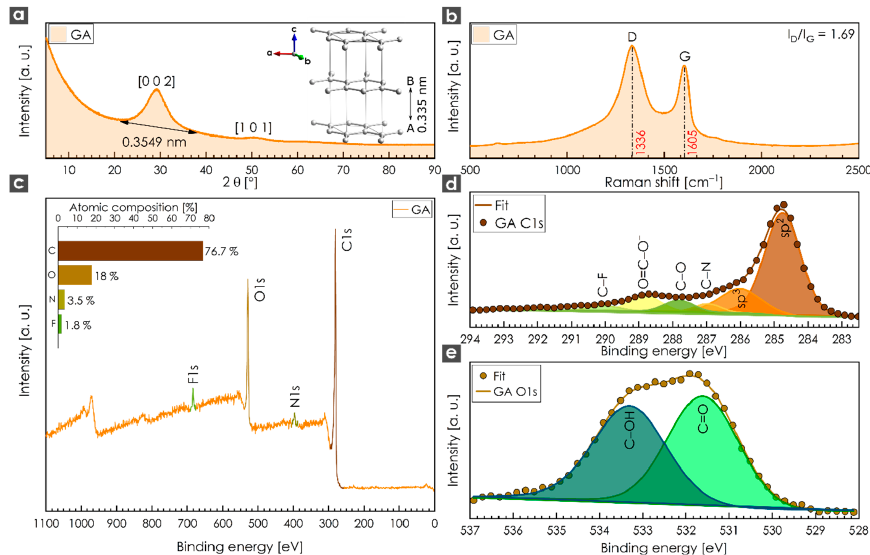
Figure 1. ( a ) X-ray diffraction (XRD) of graphene acid (GA); inset: crystal structure of graphite (hexagonal P 63 mc, a : 2.456 Å, b : 2.456 Å, c : 6.696 Å) obtained from the American Mineralogist Crystal Structure Database (database code: amcsd 0011247). The crystal structure was visualized with the program VESTA (version 3.4.7), developed by Koichi Momma and Fujio Izumi [50]. ( b ) Raman spectrum of GA with corresponding I D / I G ratio; ( c ) X-ray photoelectron spectroscopy (XPS) survey spectrum and elemental composition (inset) of GA; ( d ) XPS spectra of C 1s and ( e ) O 1s derived from the GA sample.